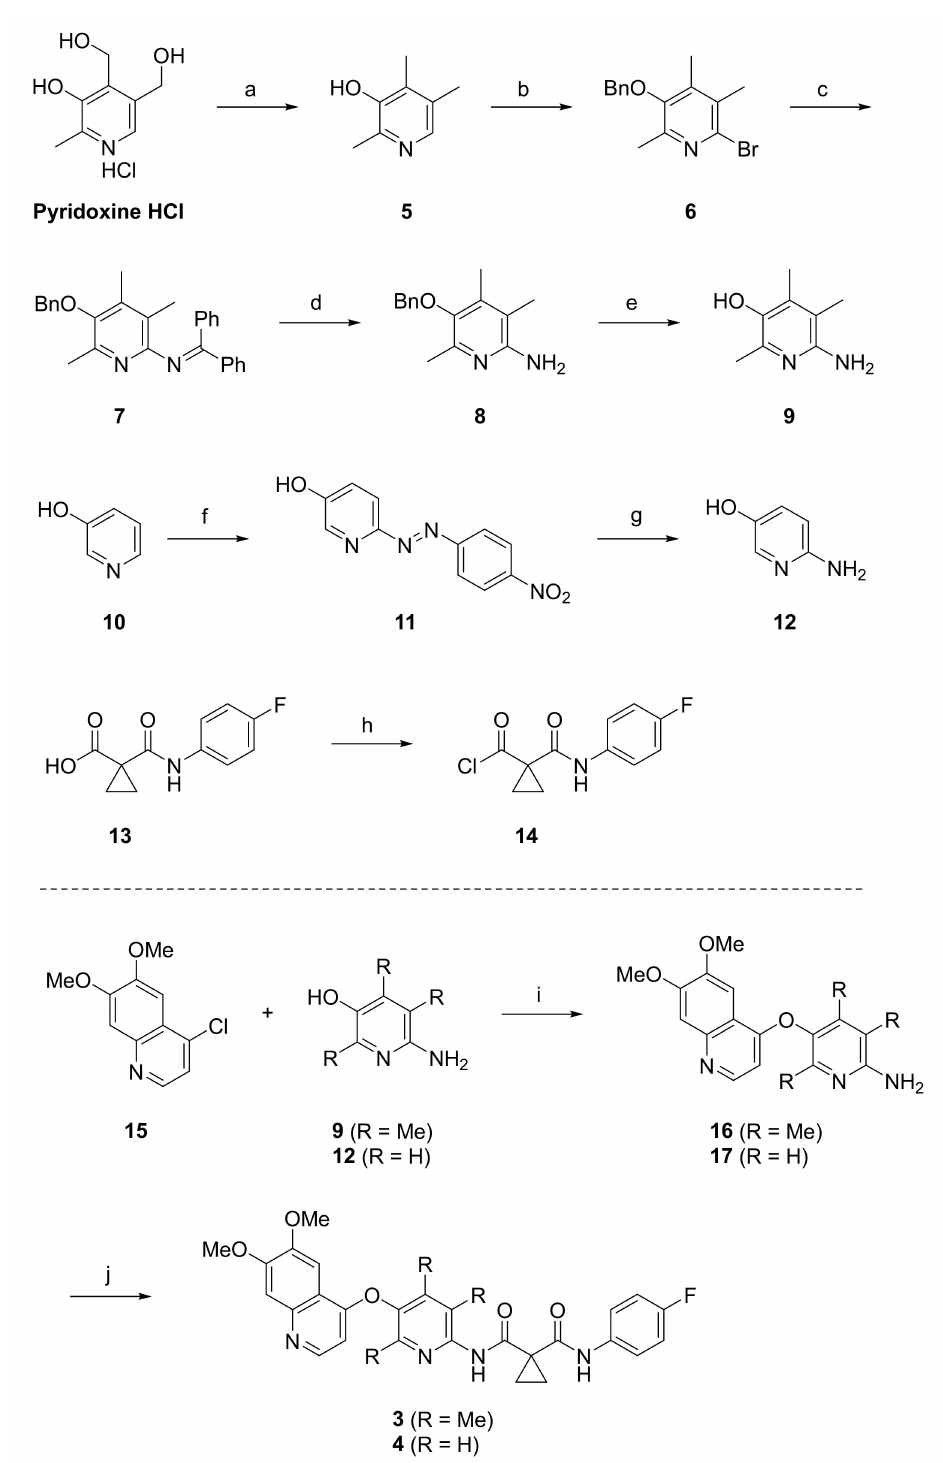
Scheme 1. Synthesis of compounds 3 and 4 . Reagents and conditions: ( a ) (i) SOCl 2 , DMF,